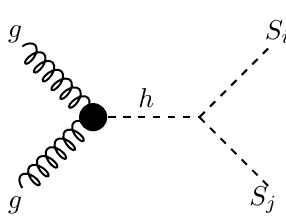
Figure 6 . The ggF-induced production of the SM-like Higgs particle at the LHC with its decay into inert particles, denoted as S i and S j